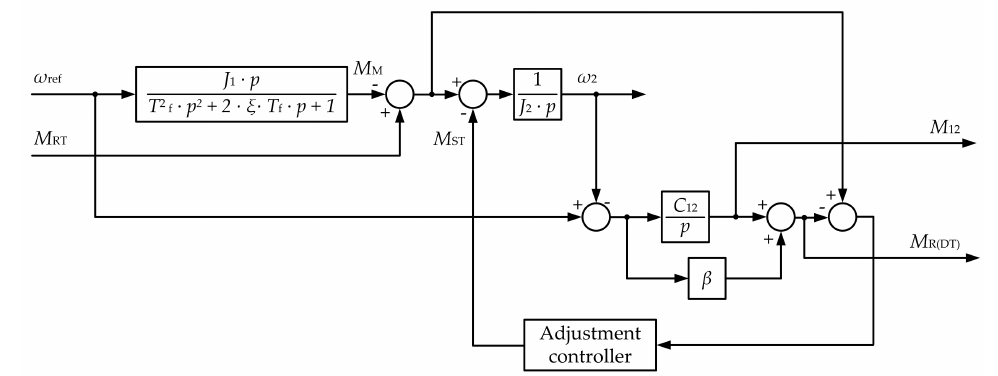
Figure 7. Block diagram of the developed observer: M R(DT) –spindle torque from observer. Pursuant to the block diagram in Figure 6a, the speed ω 2 must be reconstructible from the reference torque M RT . Motor torque M M and first mass speed ω 1 are